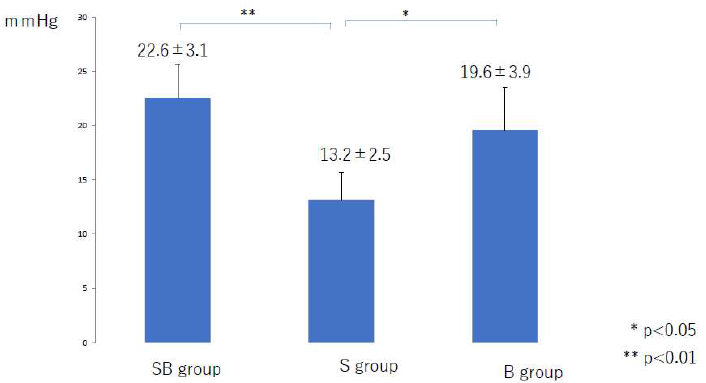
Figure 4. Mean compression applied to the lower leg after a decrease in pressure at 6 months after liposuction. B, bandage only; SB, compression stocking and bandage; S, stocking only. Figure 5. Mean compression applied to the thigh after a decrease in pressure at 6 months after lipo- suction. B, bandage only; SB, compression stocking and bandage; S, stocking only. The rate of improvement in the LEL index was significantly lower in the S group than in the SB group and in the B group (both p < 0.001) with no significant difference between